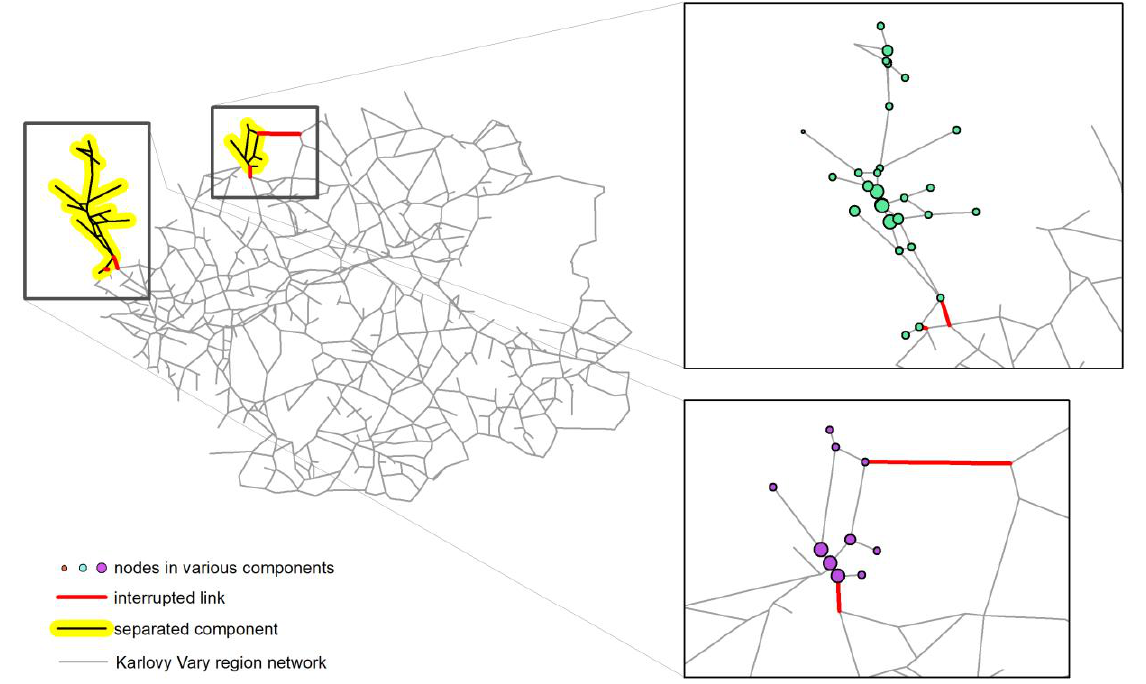
Figure 5. The worst scenario determined by ANSA for four concurrently interrupted road links in the Karlovy Vary region network. 22,024 people (6.01 %) in two components are cut off from the main network.